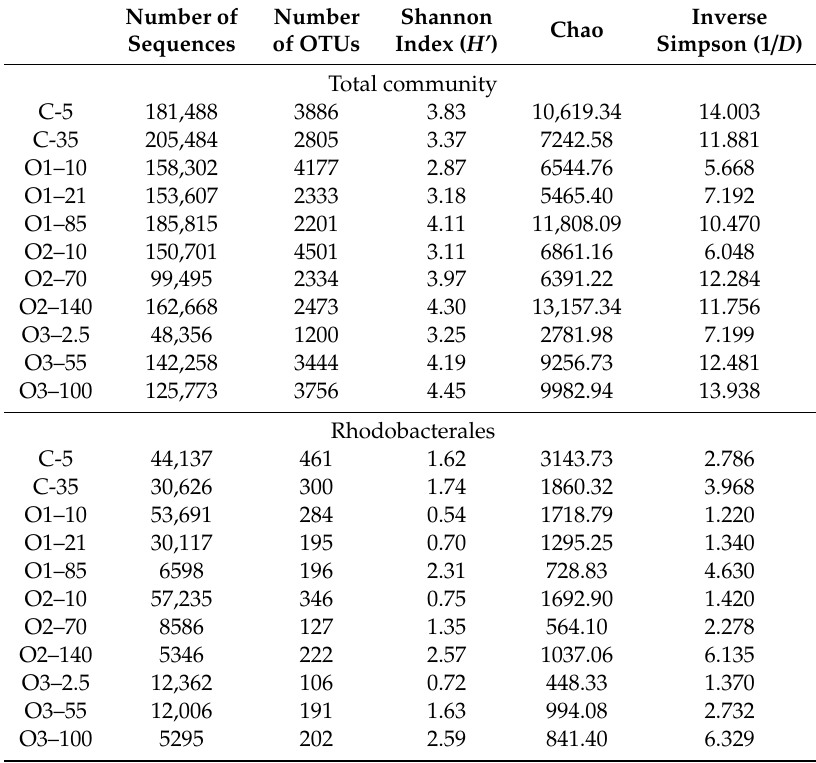
Figure 3. Comparison of the total bacterial community diversity, represented by the Shannon index, and bacterial abundance for the samples in this study. The Shannon index was calculated with OTUs defined at 97% identity. Table 3. Community characteristics for total bacterial communities, the order Rhodobacterales and Pelagibacterales for each sample.